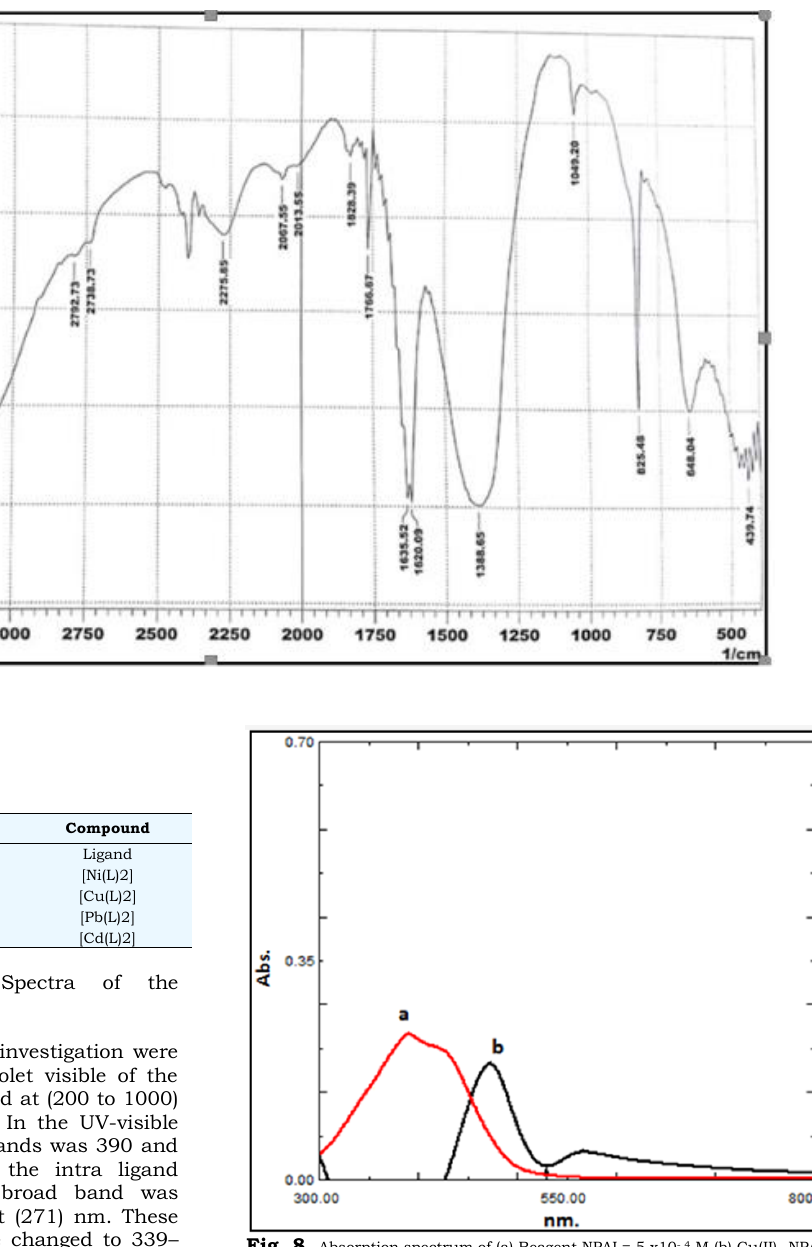
Fig. 6. FTIR – spectrum for Ni-Lcomplex